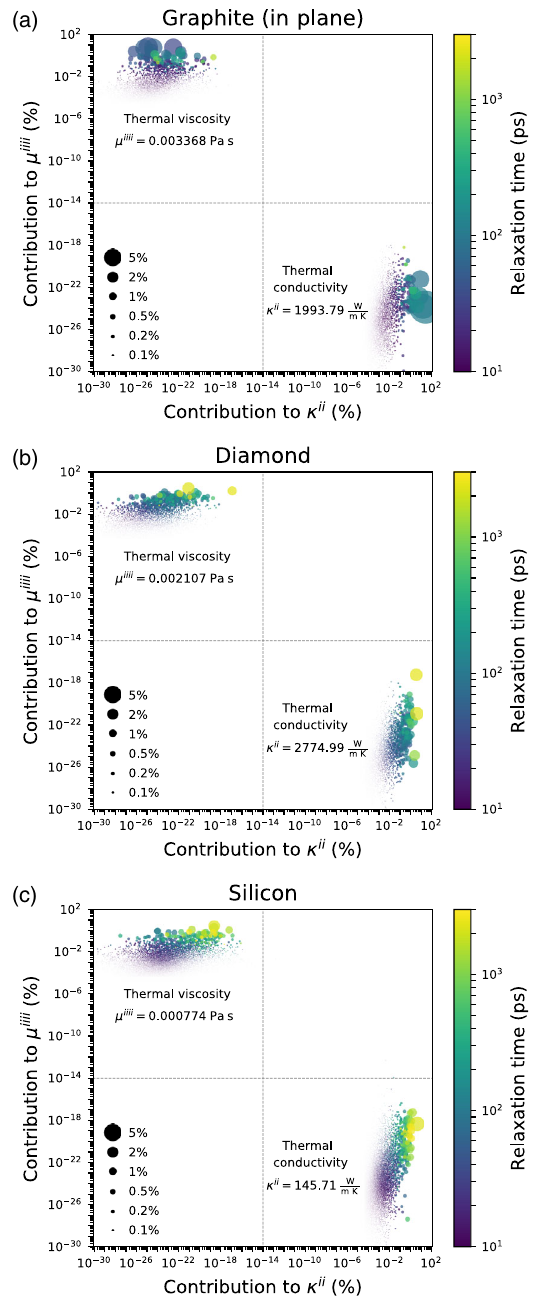
FIG. 2. Relaxons ’ contributions to the bulk thermal conduc- tivity and to the thermal viscosity at 300 K for graphite [(a), in- plane components], diamond (b), and silicon (c). Each dot represents a relaxon, with its color labeling its relaxation time, and its area being proportional to the sum of its percentage contributions to the thermal conductivity and viscosity. The dashed lines are plotted as a guide to the eye, to underscore how even and odd relaxons are fully decoupled. Odd relaxons, which determine the thermal conductivity, yield negligible (zero) contributions to the thermal viscosity; conversely, even relaxons determine the thermal viscosity and yield negligible (zero) contributions to thermal